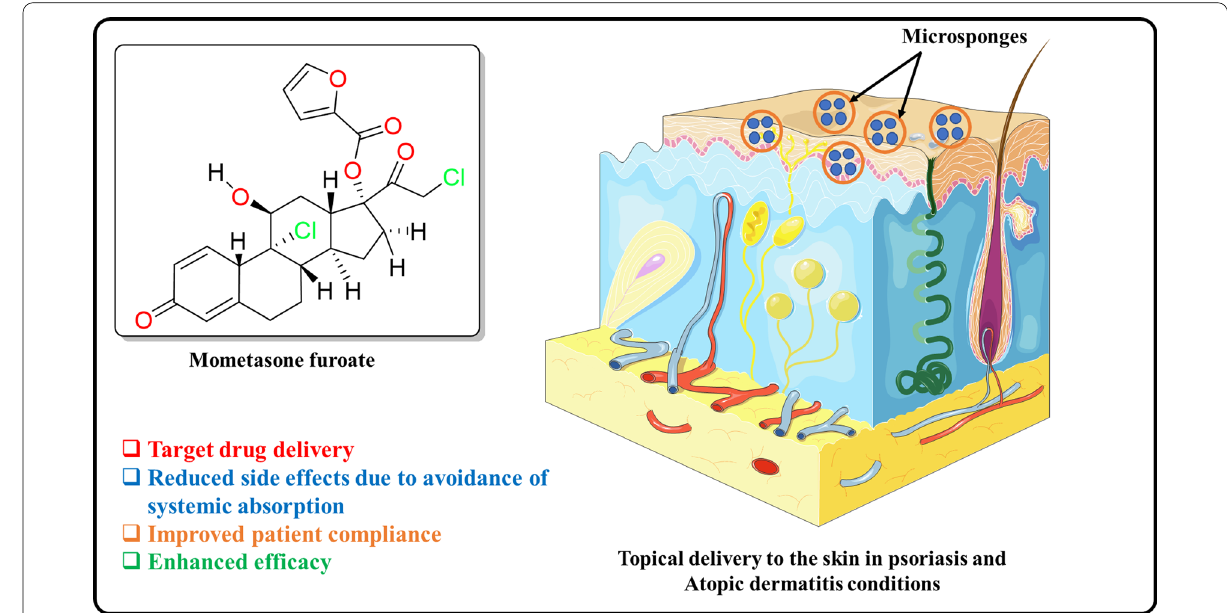
Fig. 14 Momentasone furoate microsponges in psoriasis